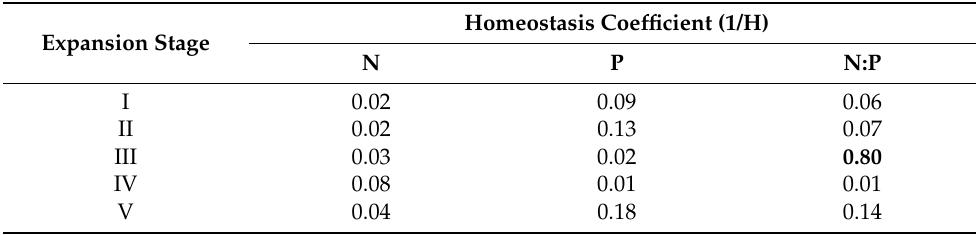
Table 3. Homeostasis characteristics of different stages during Moso bamboo expansion into Chinese fir